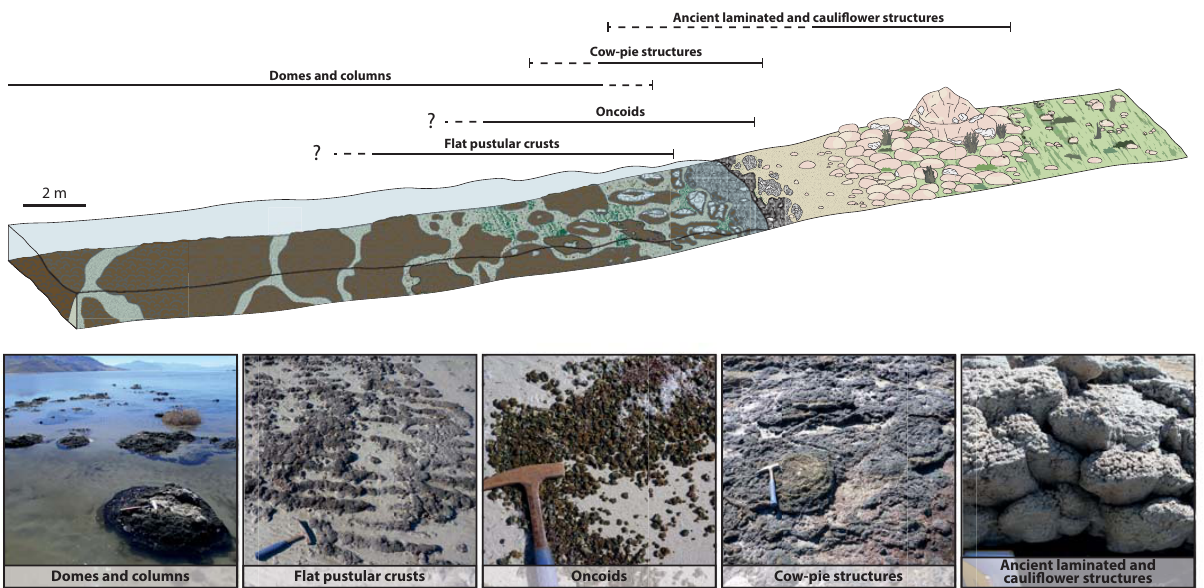
Table 1. Radiocarbon ages acquired for this paper. Lab. number